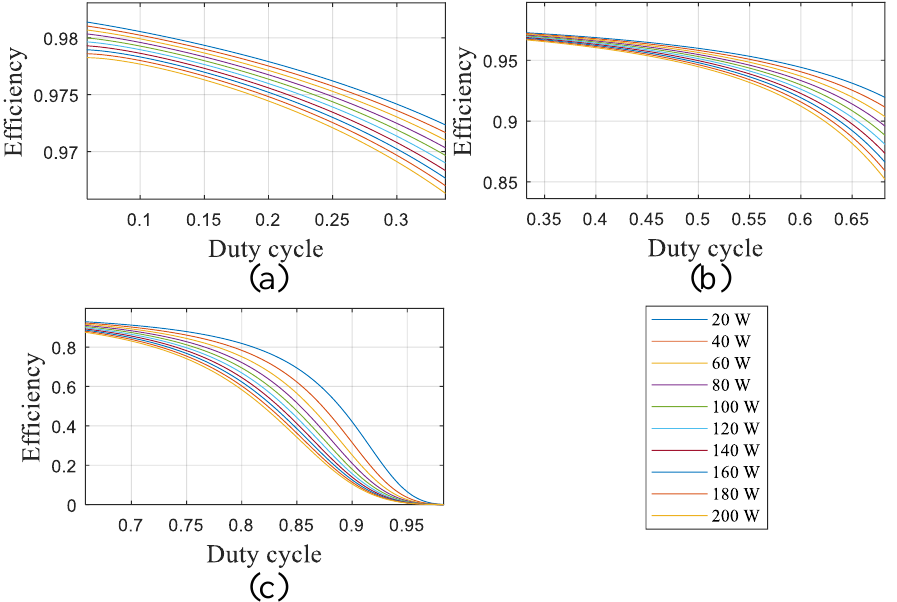
Figure 9. The efficiency comparing the various values of the output power while the duty cycle varies from: ( a ) 0 to 33%, ( b ) 33% to 66%, and ( c ) 66% from 100%.